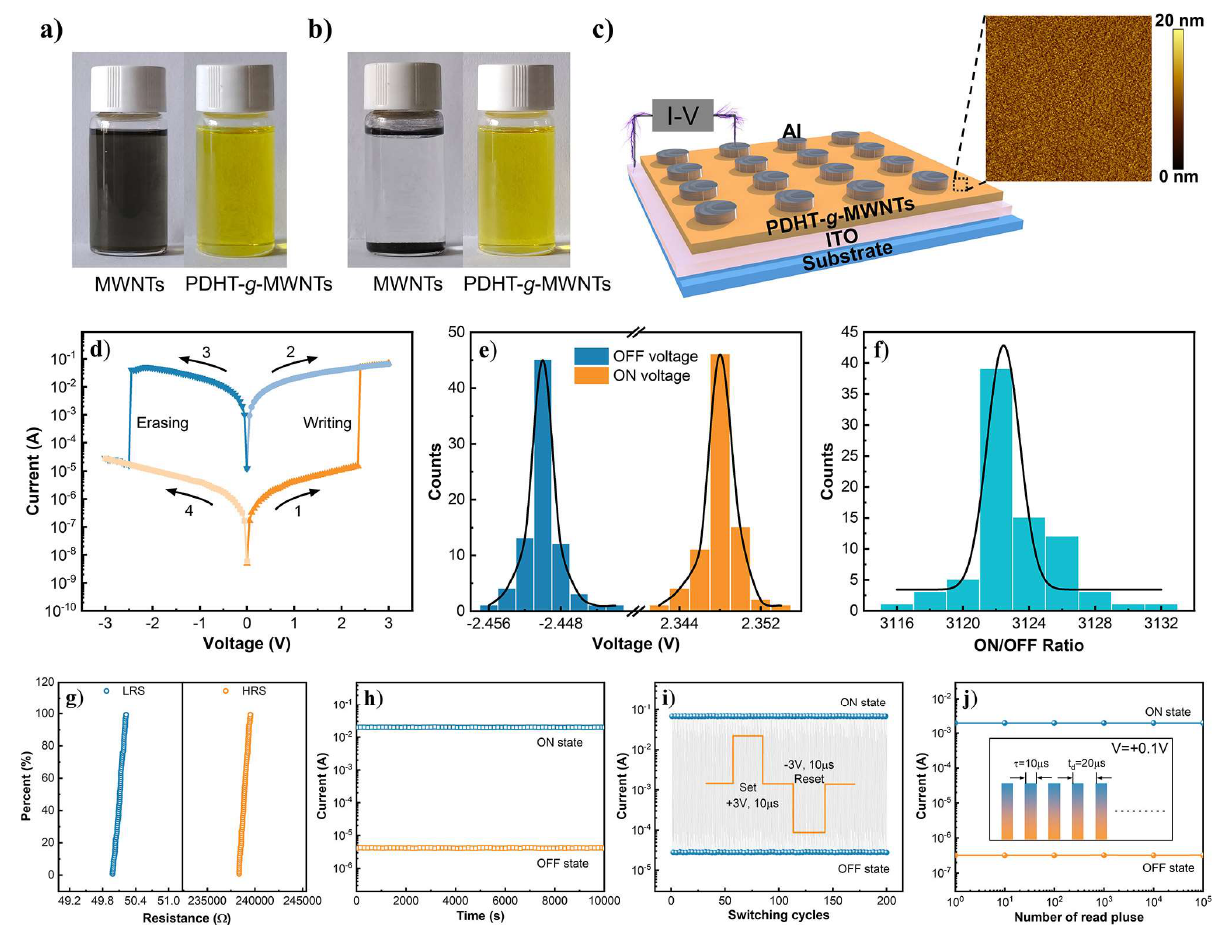
Figure 3. Digital photos of the samples dispersed in NMP: the samples dispersed immediately after sonication ( a ) and rested for 24 h after sonication ( b ). Concentration of each sample was 5 mg/mL. ( c ) An example of the memory device’s schematic. AFM picture of the PDHT- g -MWNTs film with a 10 × 10 μm 2 scanning area was shown in the right panel. ( d ) Current-voltage performance of the preparative device. ( e ) The distribution histogram of the device at OFF and ON voltages. ( f ) The distribution histogram of ON/OFF ratio of the device. ( g ) Weibull distribution of the resistance in the low resistance and high resistance states at +1.0 V. ( h ) Retention time of the device at +1.0 V in the ON and OFF states. ( i ) Al/PDHT- g -MWNTs/ITO device operating with switched voltages of ±3 V. The pulse had a width of 10 μs and a period of 40 μs. ( j ) Time stability of the Al/PDHT- g -MWNTs/ITO device’s ON and OFF states under +0.1 V pulses. The pulse had a width of 10 μs and a period of 20 μs.